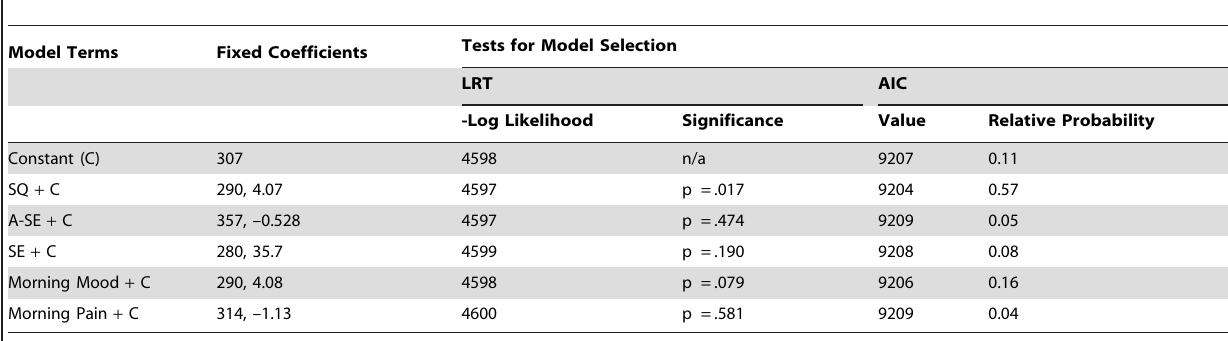
Table 1. A summary of model outcomes in predicting mean physical activity during the second half of the day (noon to 11pm).